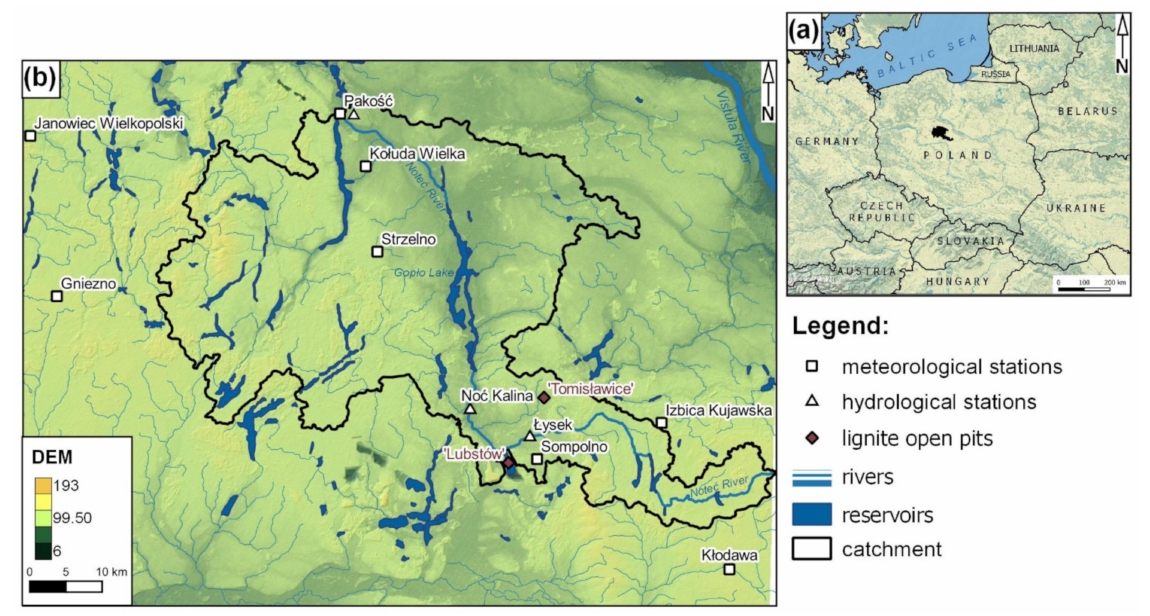
Figure 1. Study area. Source: ( a ) own elaboration made with [51,52]. Map elaborated in the coordinate system: WGS 84/UTM zone 34N; ( b ) own elaboration made with [52–54], location of the stations based on [55,56] and Table 1, location of the lignite open pits based on [56,57]. Meteorological station Izbica Kujawska is out of catchment area according to coordinates from Table 1. Location of the hydrological station Pako´s´c is determined by cartographic issues. Map elaborated in the coordinate system: WGS 84/UTM zone 34N. Table 1. Annual sum of atmospheric precipitation in the period of